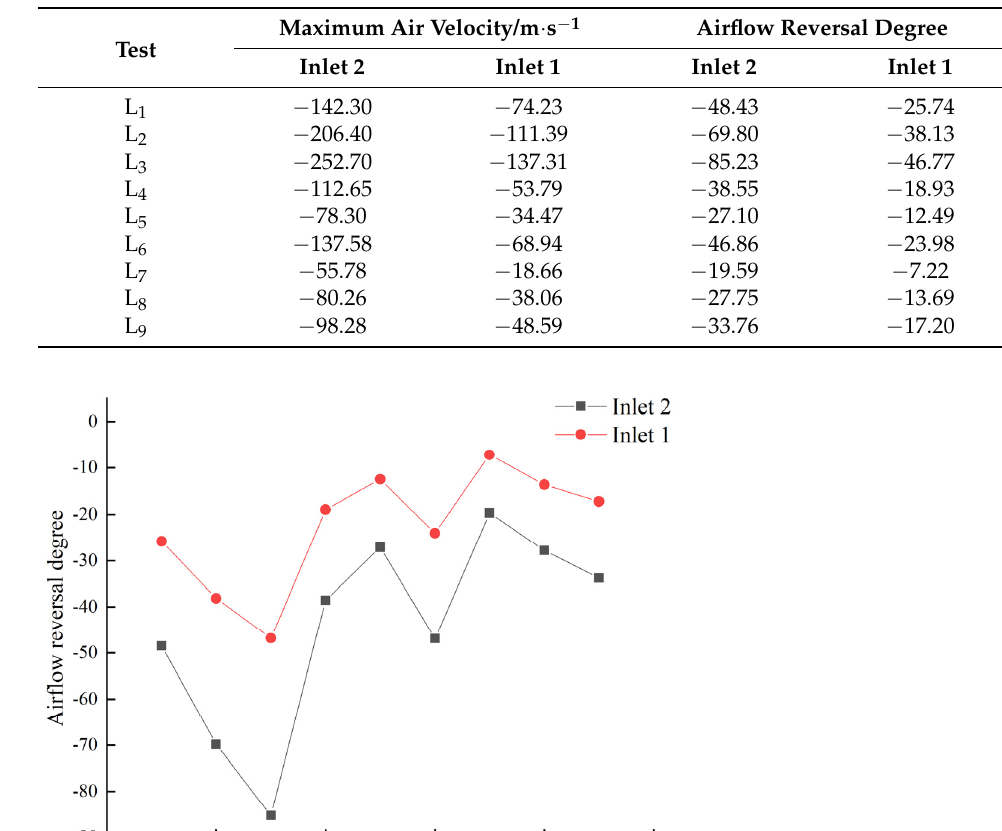
Table 4. Air velocity and airflow reversal degree of the inlet boundary.